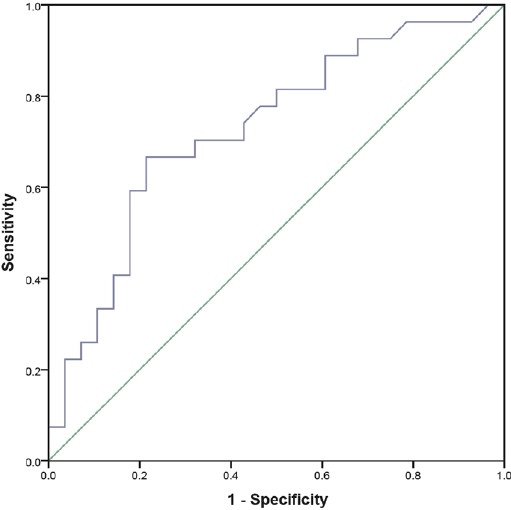
Figure 4. ROC curve for diagnostic of presence of atherosclerotic plaque in NAFLD according to cAMP- treated J774 CEC. The area under curve was 0.728 (95% CI = 0.593–0.863, P =